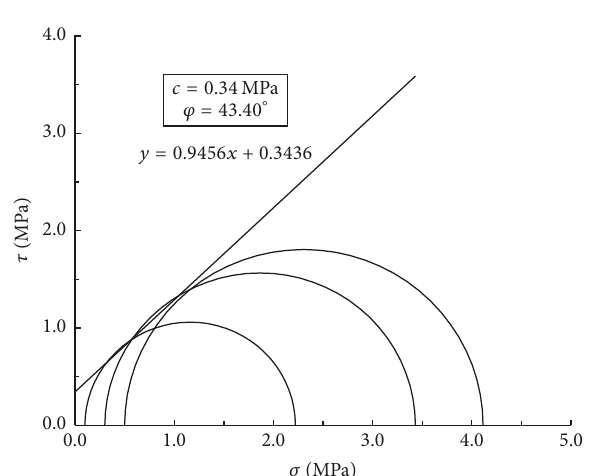
Figure 7: Mohr’s circles and strength envelope of the simulated soft rock.